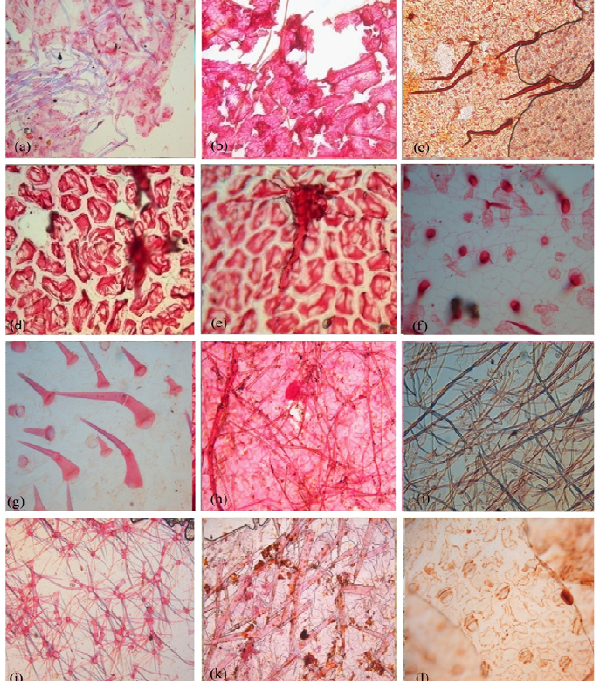
Fig. 4. a. Anemone replica (Trichomes); b. Cynoglossum glochidiatum ; c. Ranunculus brothersii ; d. Aconogonum molle (Cells); e. Aconogonum molle (Trichome); f. Marrubium vulgare (Cells); g. Marrubium vulgare (Trichomes); h. Aquilagia fragrans ; i. Potentilla eriocarpa (Trichomes); j. Verbascum thapsus ; k. Delphinium cashmerianum (Trichomes); l. Delphinium cashmerianum (Cells and Stomata)